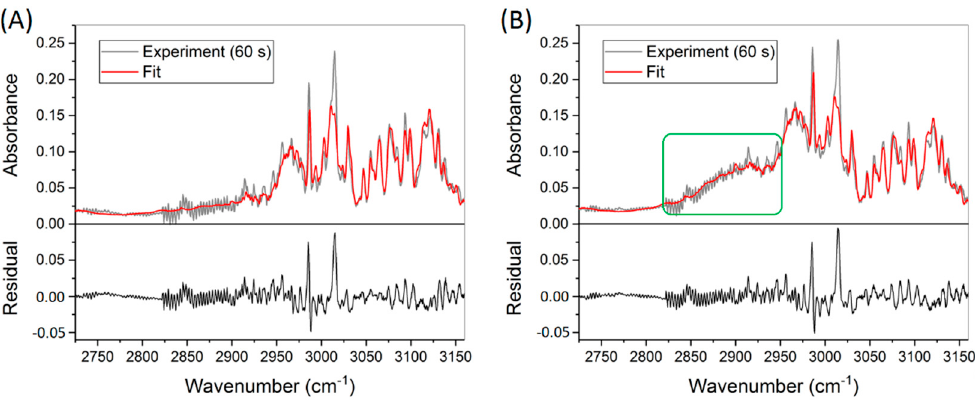
Figure 8. Measured (grey) and fitted (red) absorbance spectra associated with the first ( A ) and last ( B ) concentration data points in Figure 7. The residuals are included on the bottom. The green square in ( B ) highlights an increased ethanol concentration. A Savitzky–Golay filter is applied in the 2725–2821 cm − 1 window in order to minimize the etalon effect due to optical elements.